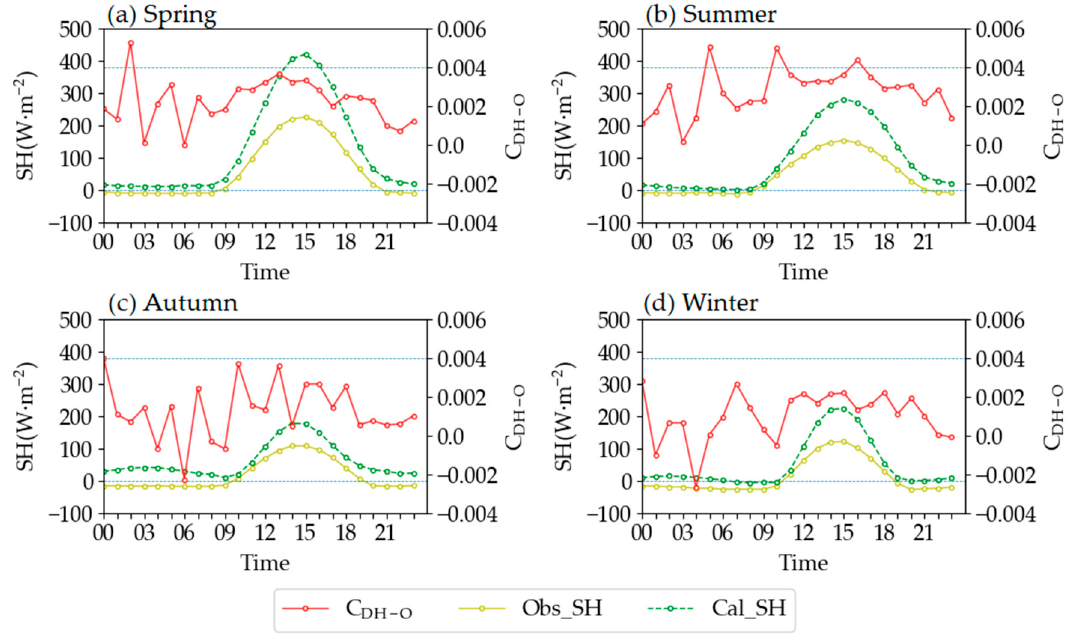
Figure 8. Seasonal mean of the diurnal variation in the derived heat transfer coefficient (C DH-O ), observed SH (Obs_SH, unit: W m − 2 ) and calculated SH (Cal_SH, unit: W m − 2 ) at NAMORS in ( a ) spring, ( b ) summer, ( c ) autumn, and ( d ) winter. The two horizontal dashed lines indicate zero SH and 0.004 C DH-O , respectively.